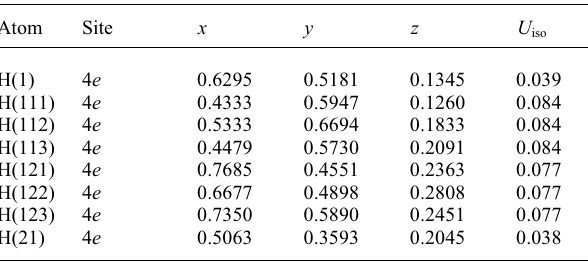
Table 2. Atomic coordinates and displacement parameters (in Å 2 ) .